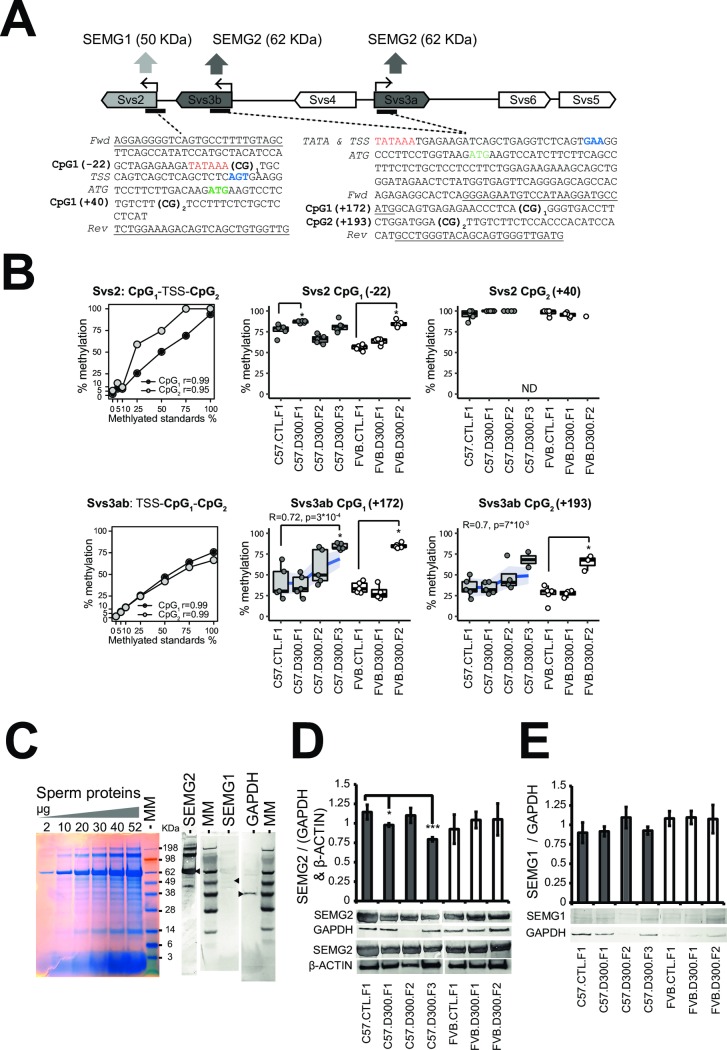
Quantifications of SEMG1-2 combined with measurements of CpG methylation levels in the Svs2 and Svs3ab promoters.(A) Design of bisulfite pyrosequencing assays to measure CpG methylation levels in the promoters of Svs2 encoding SEMG1 and Svs3a/Svs3b encoding SEMG2. Svs3a and Svs3b duplicated-inversed genes are named Svs3ab in part B. The binding sites for the forward and the biotinylated reverse primers used for the bisulfite pyrosequencing experiments are underlined in both original sequences. Two CpG sites were tested in both promoters and numerated CpG1 and CpG2. TSS: transcriptional start site as the +1 coordinate’s reference in blue. ATG: translational starts in green. TATA: tata boxes in red. (B) CpG methylation levels in both Svs2 and Svs3ab promoters were validated using a pre-mixed calibration standard (0, 5, 10, 25, 50, 75 and 100% Fig 5B and then measured in sperm-extracted DNA under each experimental conditions using bisulfite pyrosequencing in quintuplicates. *Increased methylation levels were found in three of four CpG sites of both promoters in both backgrounds in the DEHP exposed filiations compared with their respective controls; Svs2-CpG1 in C57.D300.F1 and in FVB.D300.F2 (both p<10−2); Svs3ab-CpG1 in both C57.D300.F3 and in FVB.D300.F2 (both p<10−3); Svs3ab-CpG2 in FVB.D300.F2 (p<0.04). Note that methylation levels in the C57BL/6J background correlated positively with the ordered generations in both sites tested in Svs3ab. Each point represents a measure obtained in one mouse. Some measurements did not reach quintuplicates due to full consummation of the DNA samples. (C) Electrophoresis of total sperm protein and Western blots analysis revealed that SEMG2 (62 KDa) is the major protein fraction in sperm. (D) Western blot quantifications revealing decreased SEMG2 in sperm of C57.D300.F1 (p<0.04) and C57.D300.F3 (p<0.004) compared with C57.CTL.F1. Normalization was performed relative to GAPDH (37 KDa) and β-ACTIN (42 KDa). No changes of SEMG2 were recorded in FVB/N. (E) SEMG1 (50 KDa) levels were low and unchanged across the different conditions tested.